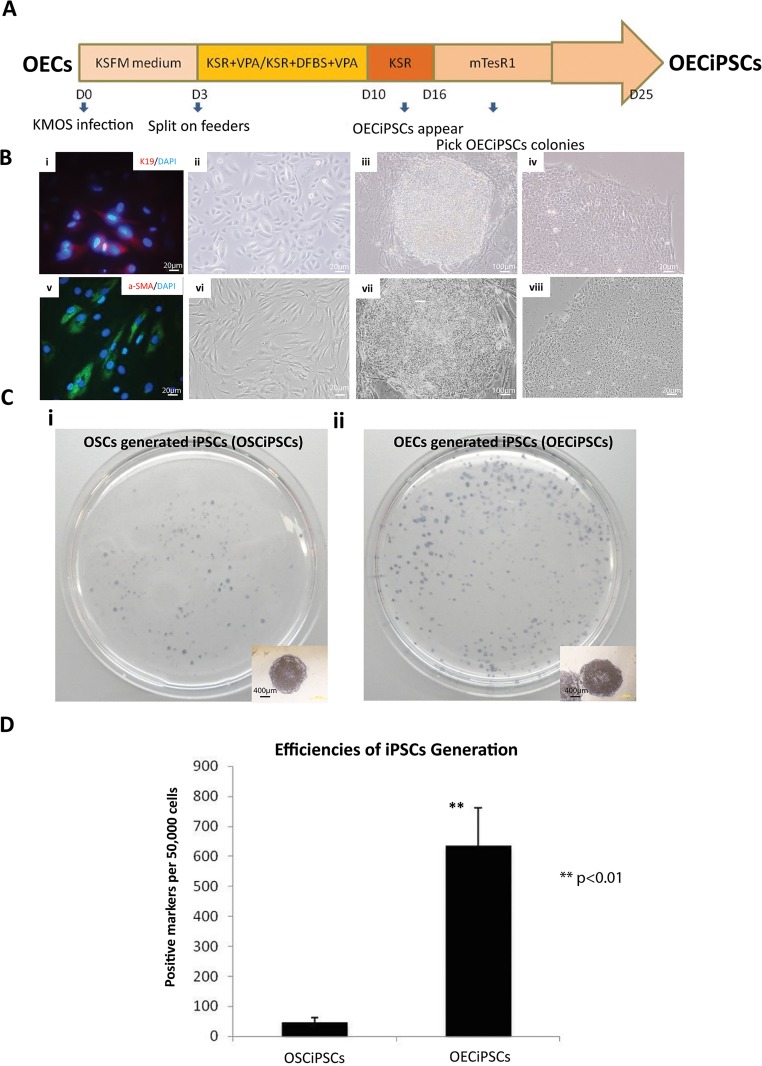
Efficiency of human iPSCs generation from OECs.
(A) Schematic representation on human iPSCs generation from human OECs. (B) Bright view images on iPSCs generation (i) OECs primary cells (ii) OECiPSCs on feeders (iii) OECiPSCs on feeder free culture. (C) Alkaline phosphatase (AP)-staining for iPSCs-like colonies derived from (i) OSCs & (ii) OECs. (D) Quantitative analysis of AP-positive iPSC-like colonies between OSCiPSCs and OECiPSCs OSC-iPSCs vs OEC-iPSCs: (46.33±15.50; 635±127.57) (SD; N = 3, **P<0.01).